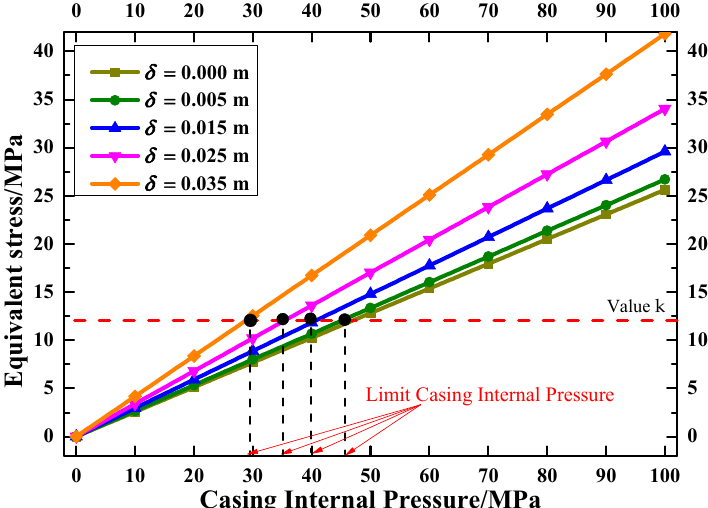
Figure 12. Variation of equivalent stress with the increase of casing internal pressure in different eccentricities, δ .